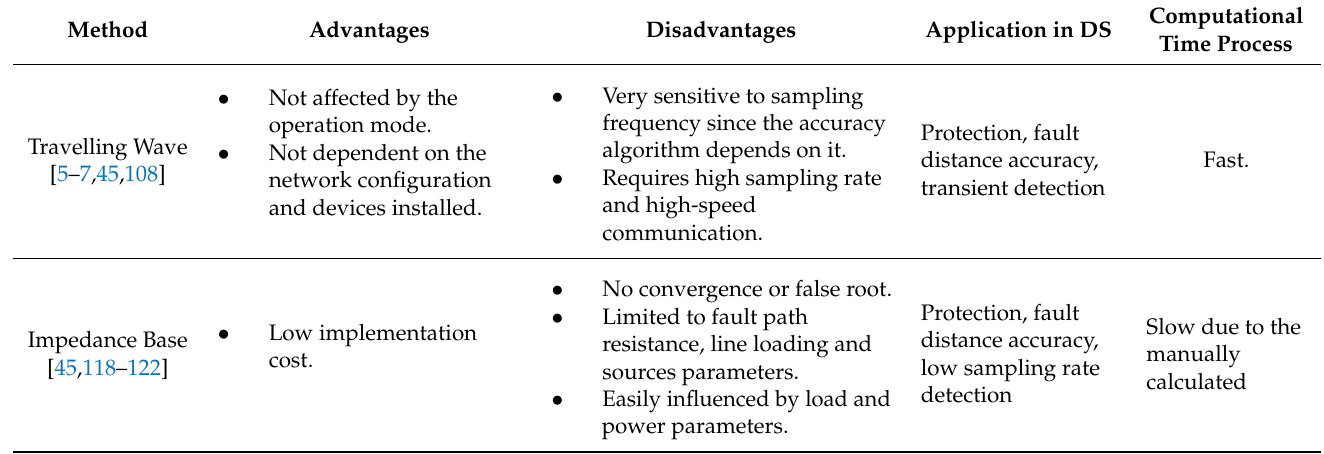
Table 8. Advantages and disadvantages of fault detection